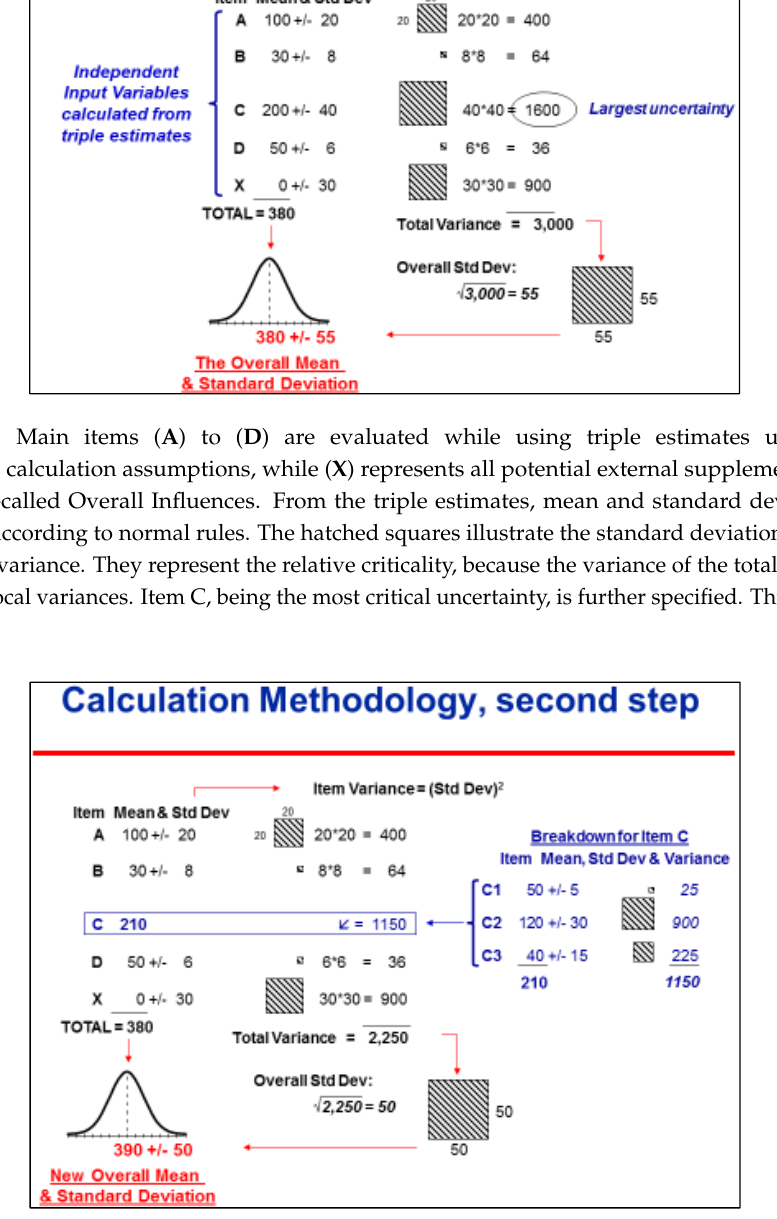
Figure 4. As illustrated in Figure 3, ( C ), being the most critical, is now specified into sub items. A triple estimate is made of each of these. The calculation is updated with these new estimates. The next step will be a specification of ( X ), now being the most critical, into a set of independent external potential effects—the Overall Influences. Refer to the examples in Figure 2. When all dominating uncertainties are handled in the following steps, the calculation procedure is finalized.